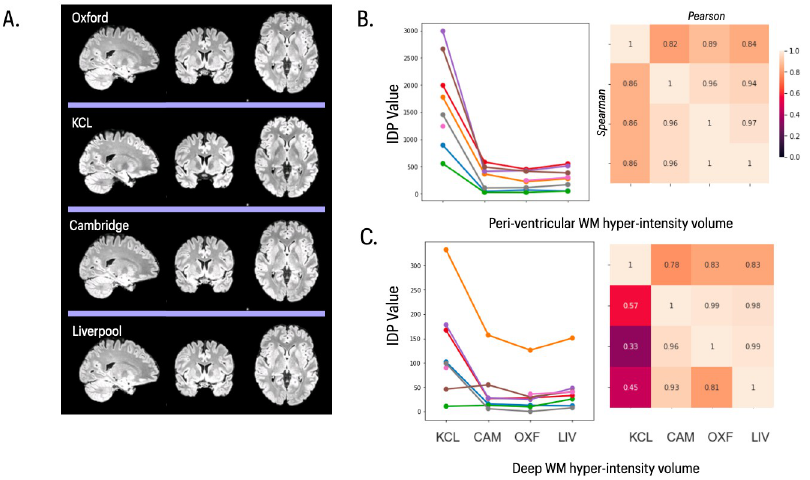
Fig 3. T2 FLAIR images and statistical results for T2-derived IDPs. A) Representative T2 FLAIR images of the same subject scanned at each of 4 sites in the travelling heads study. B) left panel , peri-ventricular white matter hyperintensity volume for 8 subjects (coloured lines) scanned at each of 4 sites (x-axis labels); right panel , correlations between each pair of sites. C) left panel , deep white matter hyperintensity volume for 8 subjects (coloured lines) scanned at each of 4 sites (x-axis labels); right panel , correlations between each pair of sites. In both B) and C) , the upper triangle of the matrix shows Pearson’s correlations and the lower triangle shows Spearman’s correlations; and both IDPs were estimated using